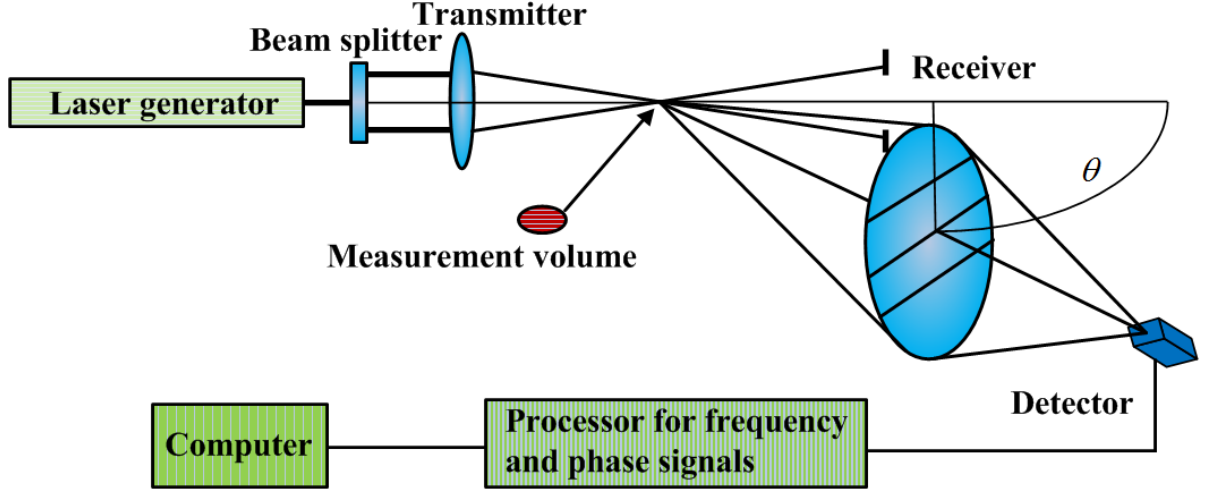
Figure 1. Schematic diagram of phase Doppler anemometry system and jet flow